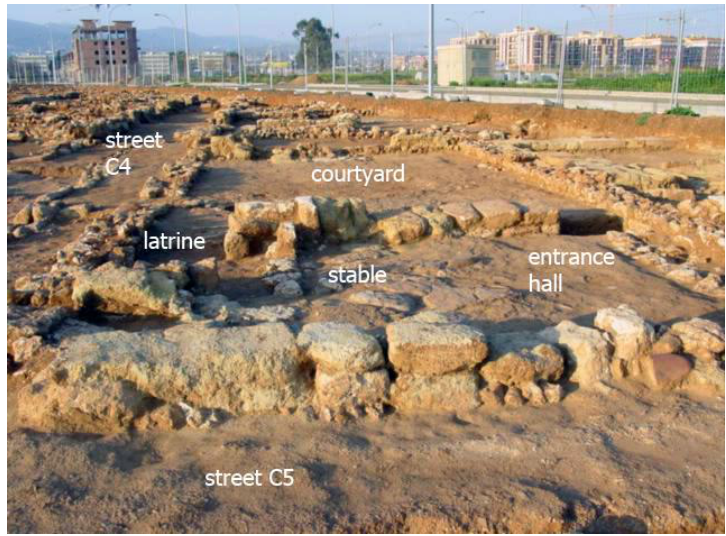
Figure 8. House 37. Entrance hall and paved stable.